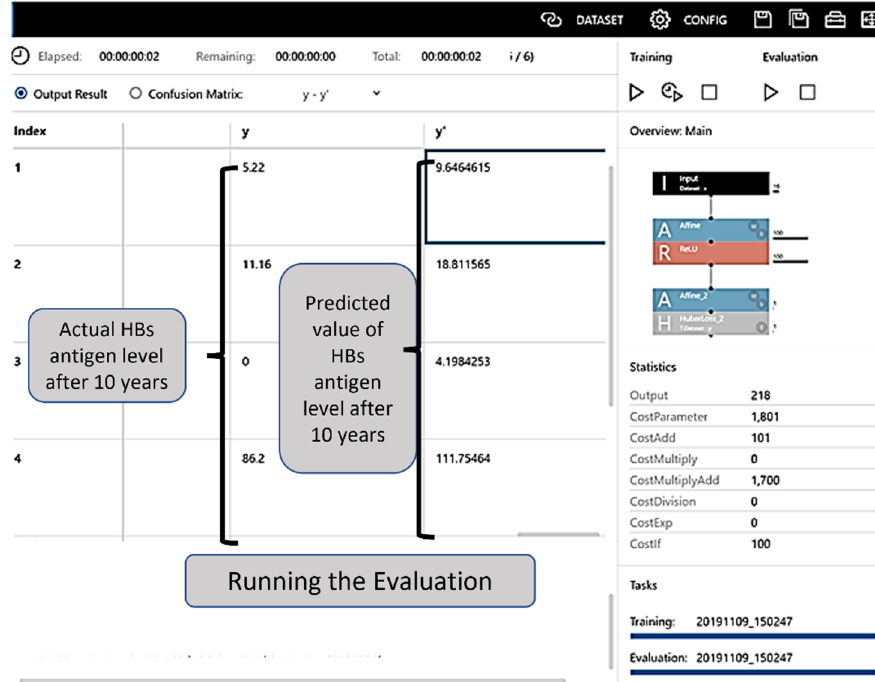
Figure 3. Evaluation table. The evaluation result can be checked in the Evaluation tab, and the evaluation is initiated when the Confusion Matrix tab is clicked and “estimated y” is displayed. HBs: hepatitis B